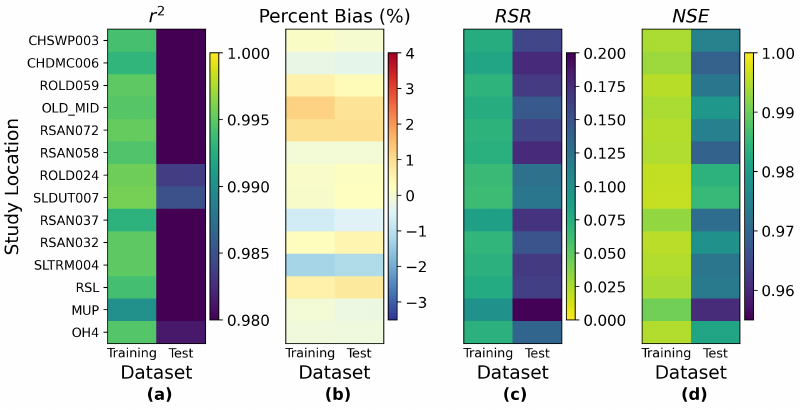
Figure A19. Model (grouped ResNet) performance measured by ( a ) r 2 , ( b ) Percent Bias, ( c ) RSR, and ( d ) NSE on training and test set at the study locations belonging to the interior Delta group.